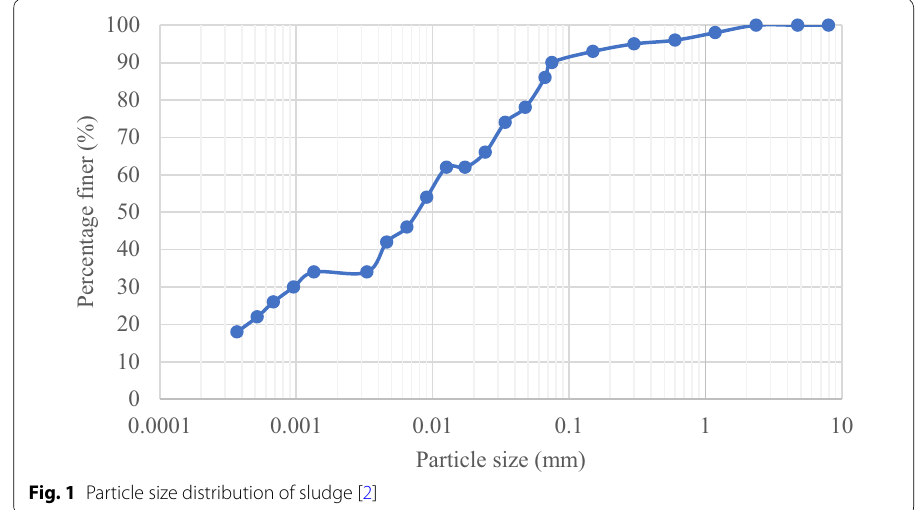
Fig. 1 Particle size distribution of sludge [2]